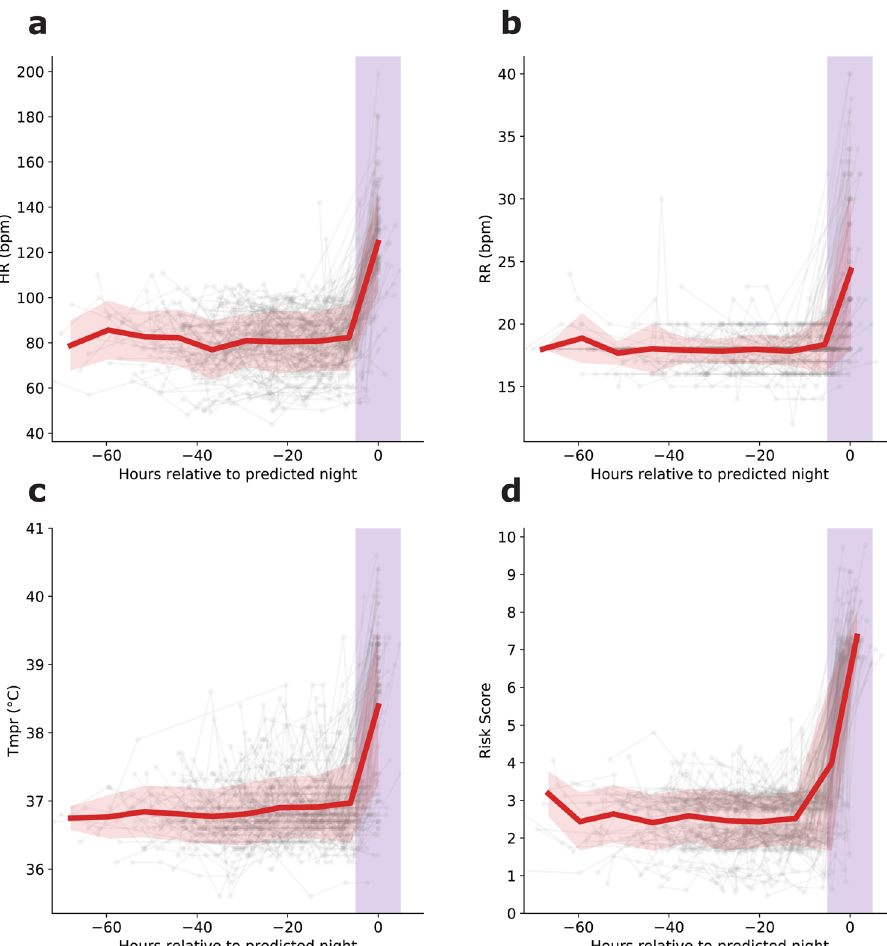
Fig. 4 Trajectories of vital signs and risk scores preceding false-positive predictions. The vital sign and risk score trajectories of patients in the 72 h prior to erroneous predictions of overnight stability (false-positive). The vital signs and risk scores are largely stable with no suggestion of risk, but abruptly worsen during the overnight period. Red line represents mean trajectory; pink band covers two standard deviations; purple band demarcates the unstable night. Risk score indicates Modi fi ed Early Warning Score (MEWS), HR heart rate (b.p.m.), RR respiratory rate (b.p.m.), Tmpr temperature